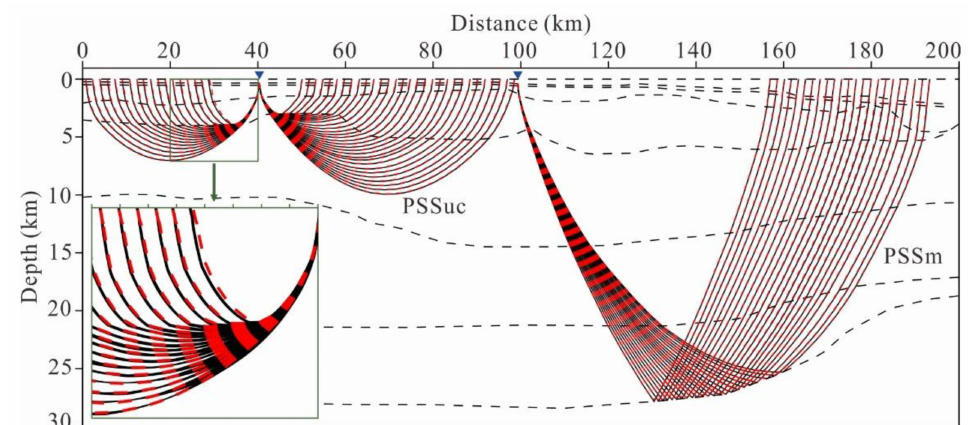
Figure 8. Comparison of the ray paths before and after the PSS phases’ travel-time correction; The red dotted lines represent the original ray path, and the black solid lines represent the corrected ray path. The left-lower map shows a partial enlarged view of the 20–40 km in the